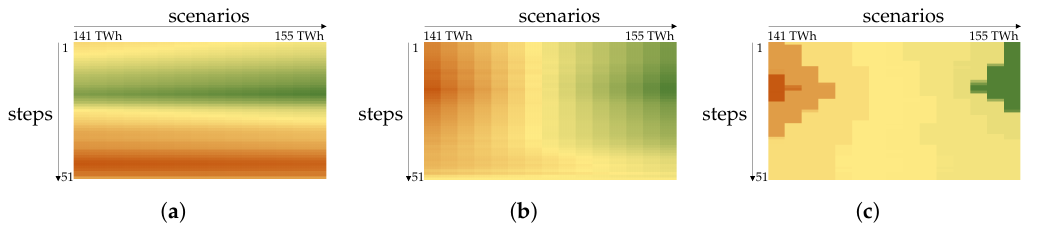
Figure A3. Ratios and prices for Figure 10b for model run EM 8 (Scenarios: 141 TWh–155 TWh). ( a ) ratio 1; ( b ) ratio 2; ( c ) scenario